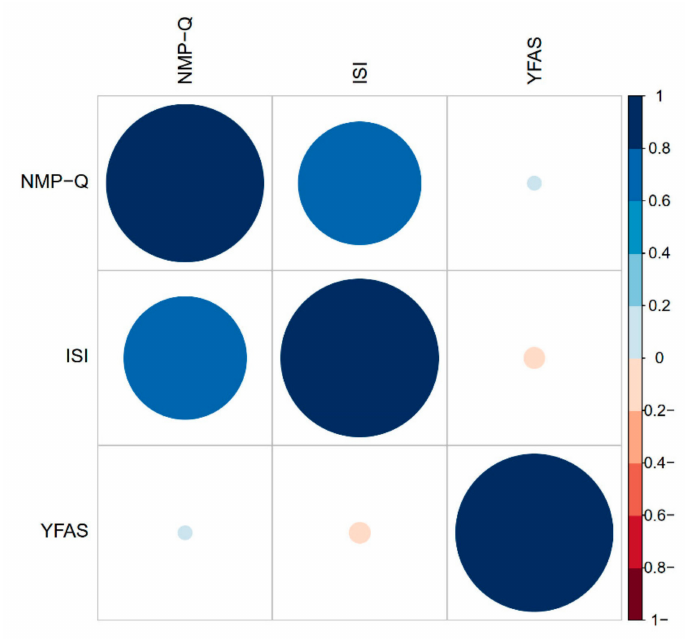
Figure 1. Correlogram of Nomophobia Questionnaire (NMP-Q), Insomnia Severity Index (ISI), and Yale Food Addiction Scale